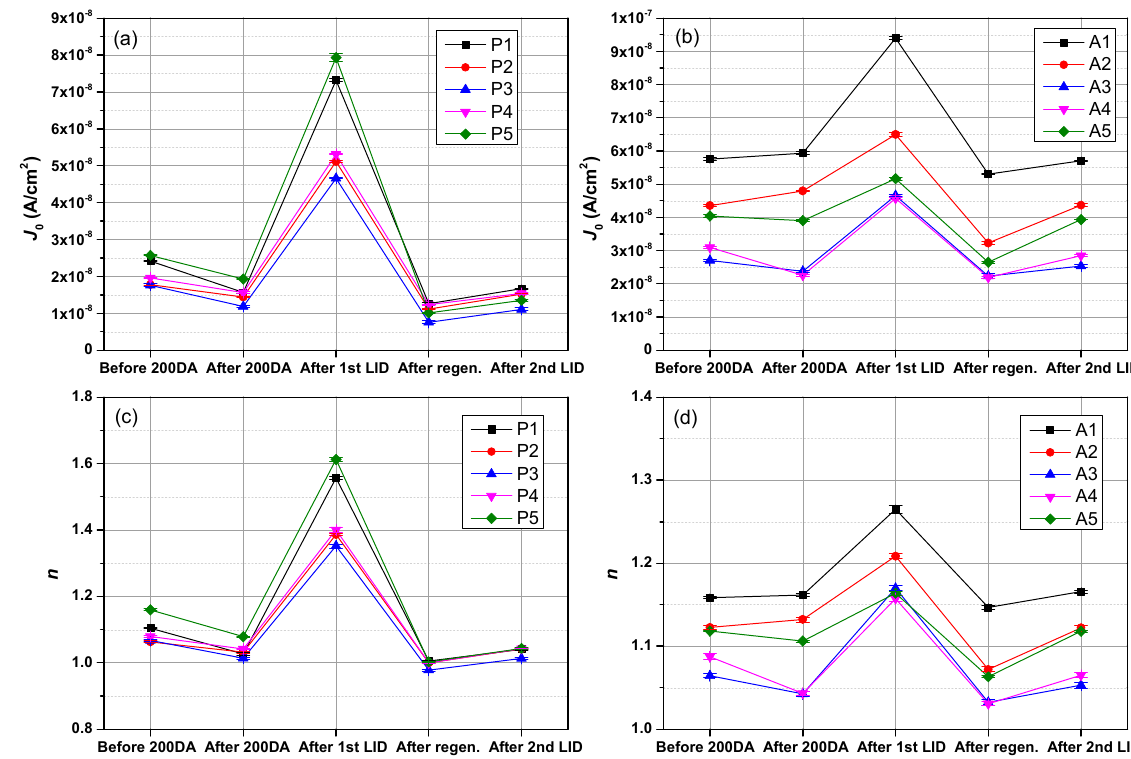
Figure 4. The variations of dark saturation current density J 0 and the diode ideality factor n of five groups of PERC ( left column) and Al-BSF cells ( right column) with process steps. (a) J 0 of PERC cells; (b) J 0 of Al-BSF cells; (c) n of PERC cells; (d) n of Al-BSF cells.